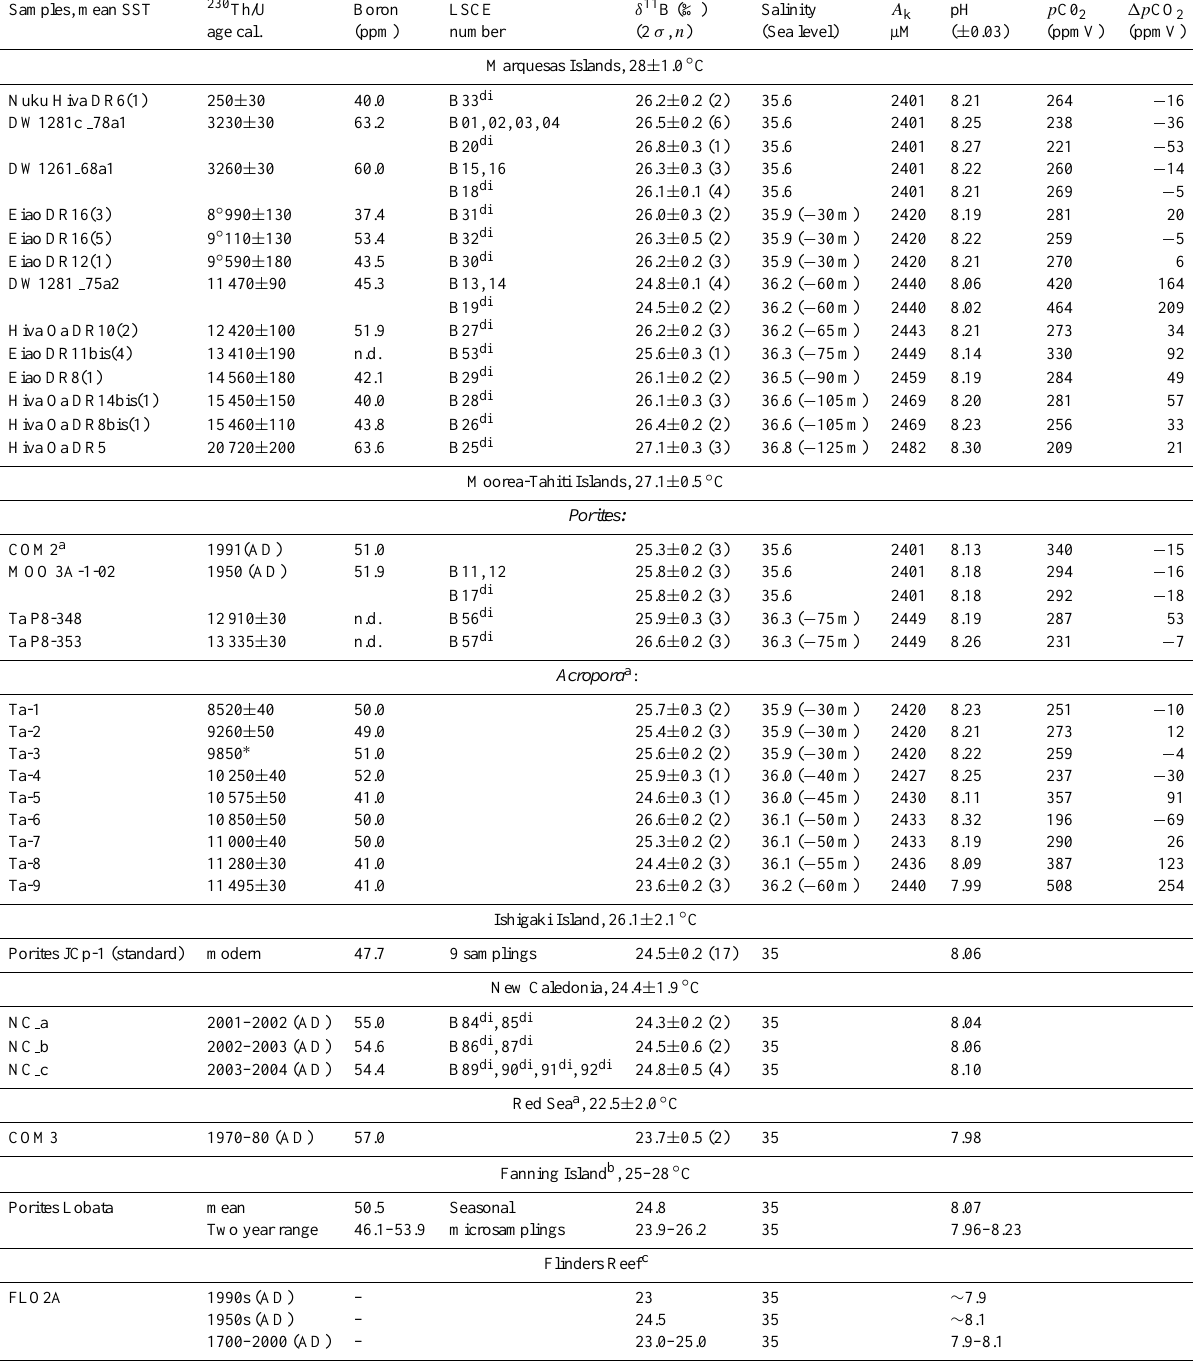
Table 1. Isotopic composition of boron δ 11 B (‰) and boron concentrations measured for coral and seawater samples. The 1p CO 2 calcula- tion is detailed in the text. The previously published δ 11 B data for corals includes a Gaillardet and All`egre, 1995; b Hemming et al., 1998; and c Pelejero et al., 2005. The 230 Th/U ages of the corals from Tahiti and Marquesas are from Bard et al. (1996), Cabioch et al. (2008), Paterne et al. (2004). ∗ 230 Th/U age of the sample Ta-3 is the former date published by Gaillardet and All`egre (1995). SST sources: (http://www.nodc.noaa.gov (Boiseau, 1998; Gertman and Brenner, 2004; Heiss et al., 1999; Henin and Cresswell, 2005). Samples, mean